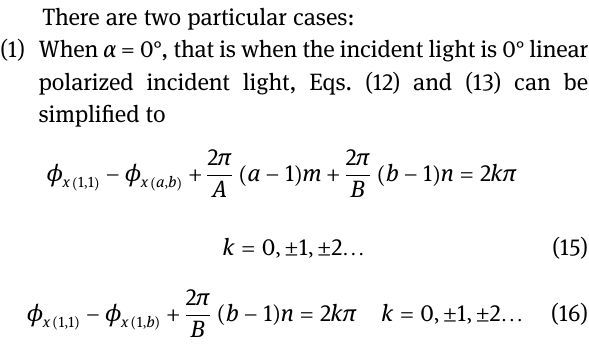
Left-handed circularly polarized light: